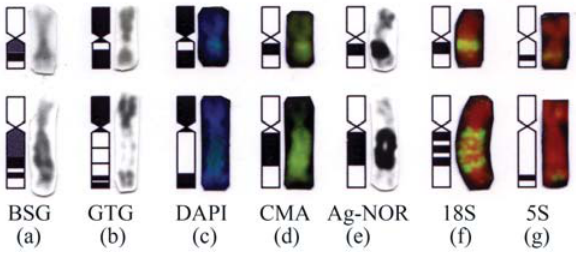
Figure 3 - Idiogram of Prochilodus lineatus showing the NOR polymor- phism on the 4 th chromosome pair and syntenic 5S site: (a) C-banding, (b) GTG-banding, (c) DAPI staining, (d) Chromomycin A 3 staining, (e) Ag-NOR sites, (f) 18S rDNA FISH and (g) 5S rDNA